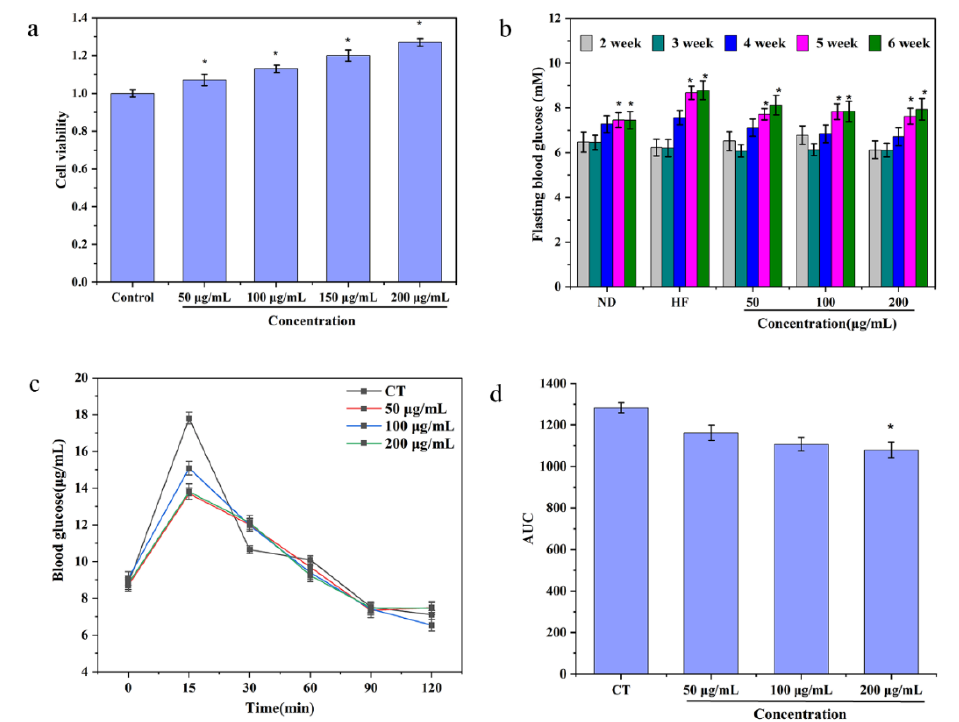
Figure 5. ( a ) The cytotoxicity effect of Pan on Caco-2 cells. Groups bearing * differ significantly at p < 0.05 with the control group (PBS-treated cells). ( b ) The levels of FBG in mice after 6 h fasts being fed normal diets (ND group), HFDs (HF group), and HFDs supplemented with 50 msg/kg/d Pan (50, 100 and 200 μg/mL treatment groups). Groups within the same week bearing * differ significantly at p < 0.05. ( c ) Suppression of blood glucose levels in OGTT by different concentrations of Pan. ( d ) Areas under the curves (AUC). Groups bearing * differ significantly at p < 0.05 against the CT group.